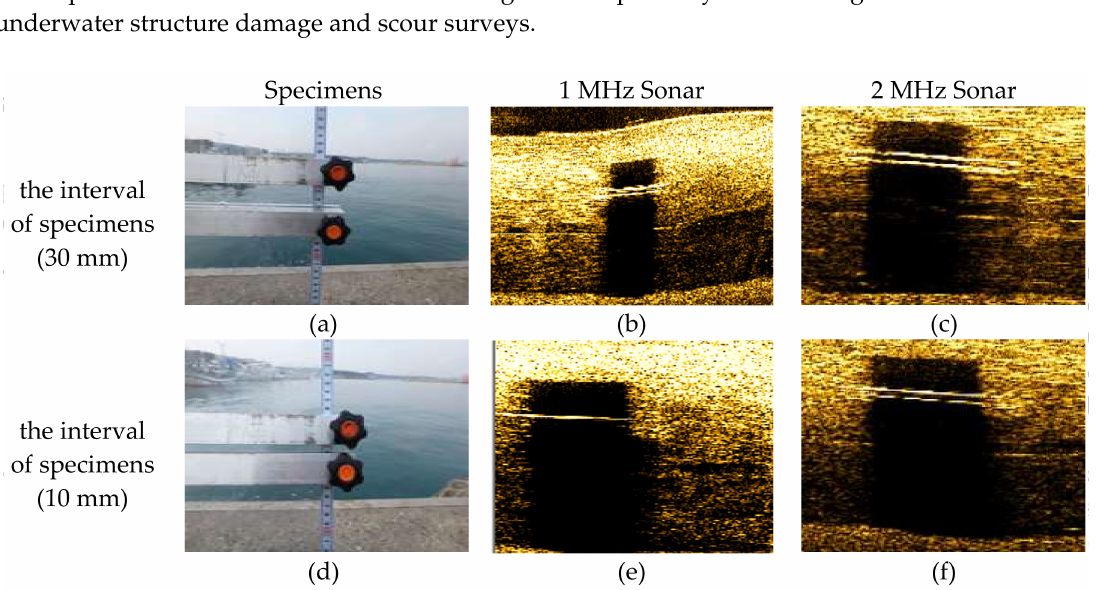
Figure 6. Resolution test in field. ( a ) Specimens (30 mm); ( b ) 1 MHz Sonar (30 mm); ( c ) 2 MHz Sonar (30 mm); ( d ) Specimens (10 mm); ( e ) 1 MHz Sonar (10 mm); ( f ) 2 MHz Sonar (10